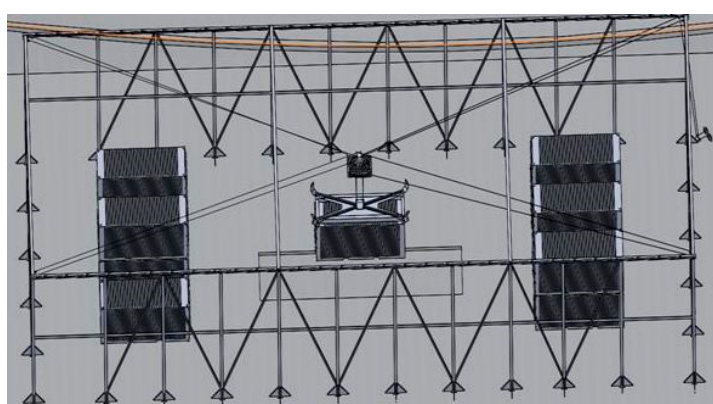
Figure 4. Diagram of the arrangement of the containers in the hold.